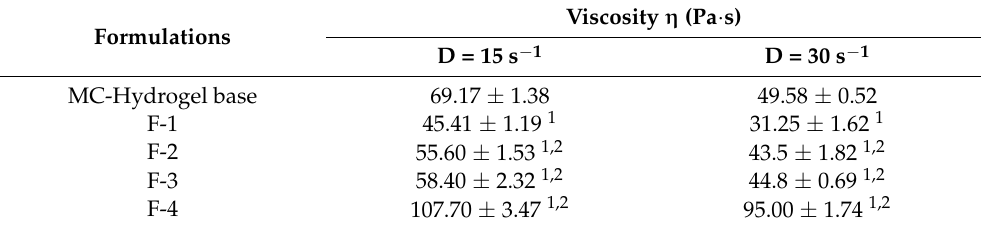
Table 5. Viscosity ( η ) of prepared hydrogels with STH (F-1), STH and ALB (F-2–F-4), and